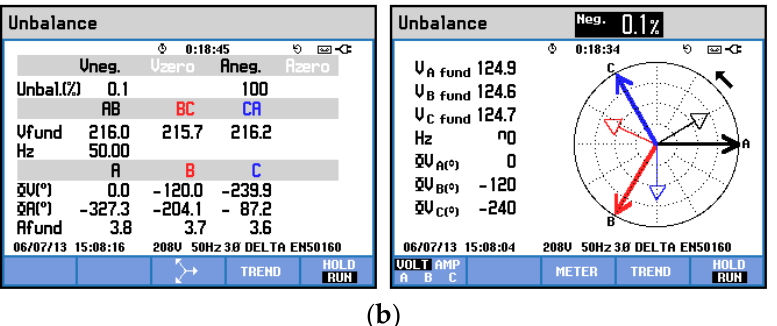
Figure 11. Three-phase voltage unbalance: ( a ) without compensation and ( b ) with compensation.